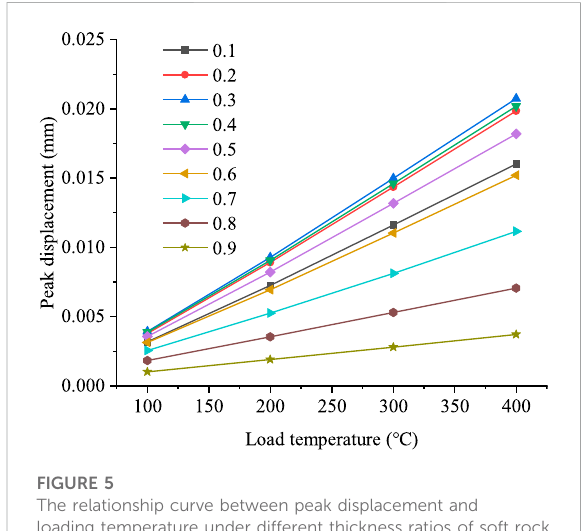
FIGURE 6 Peak contact force versus soft rock thickness ratio ( Hs/H ) under different temperature